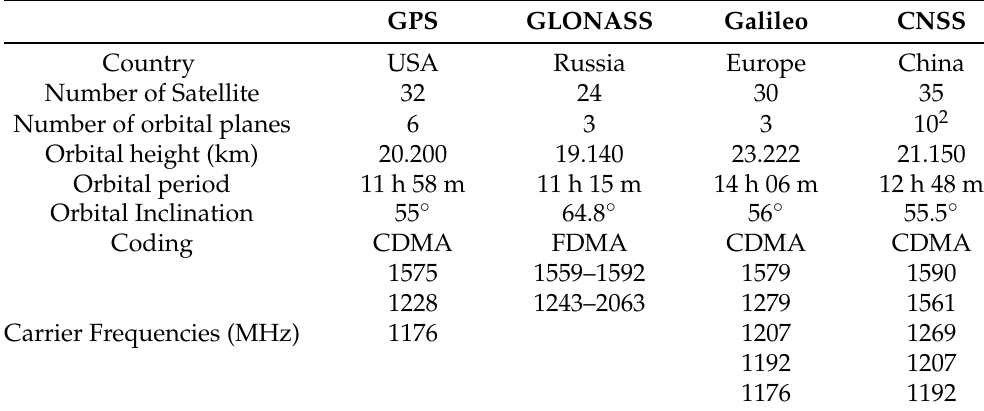
Table 1. Comparison of various